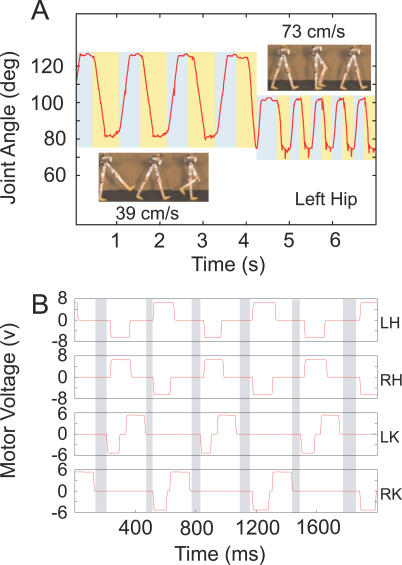
Real-Time Data of Walking Experiments(A) The joint angle of the left hip recorded during walking and changing speed on the fly. Parameters are changed greatly and abruptly for all extensor sensor thresholds of hip joints from ΘSE = 120.0 deg to 93.0 deg and for all hip motor neuron gain values from g = 1.55 to 3.0. This way speed changed from 39 cm/s (≈1.7 leg-length/s) to 73 cm/s (≈3.17 leg-length/s). At fast walking speed (73 cm/s, ≈3.17 leg-length/s), RunBot performs two steps per second, which is related to normal human walking speed [82]. Light blue areas indicate the swing phase of the left leg and light yellow areas are the stance phase.(B) Motor voltages directly sent from the leg motor neurons to the servo amplifiers while the robot is walking: LH, left hip; RH, right hip; LK, left knee; RK ,right knee. Gray areas indicate when all four motor voltages remain zero during some stage of every step cycle where the robot walks passively. Due to an appropriate weight of the limb together with the generated velocity, it leads to a momentum which is high enough to rotate the joint and swing the leg into the desired position although the motor voltages are zero, while the gear fiction will decrease the acceleration. Note that the controller of the RunBot system is implemented on a 2-GHz PC, and the data information is processed at a certain number of steps with the update frequency of 250 Hz.